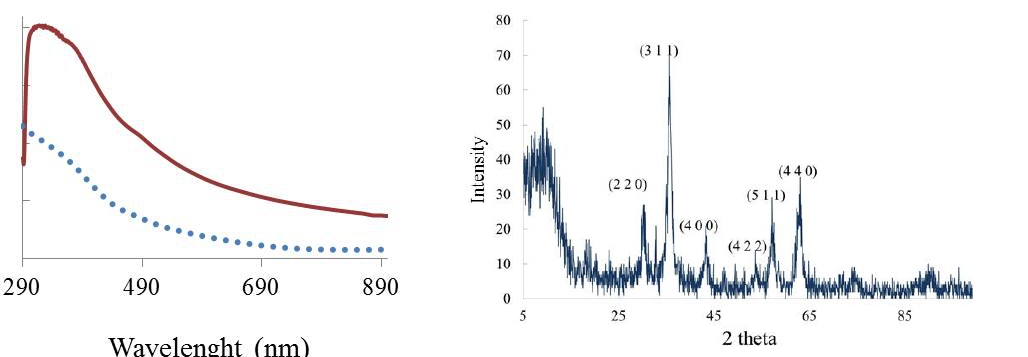
Fig. 4 UV–visible spectra of the naked (Dot line) and β -CD modified (Solid line) Fig. 4. UV–visible spectra of the naked (Dot line) and β-CD modified (Solid line) Fe O nanoparticles Fe 3 O 4 nanoparticles. 3 4